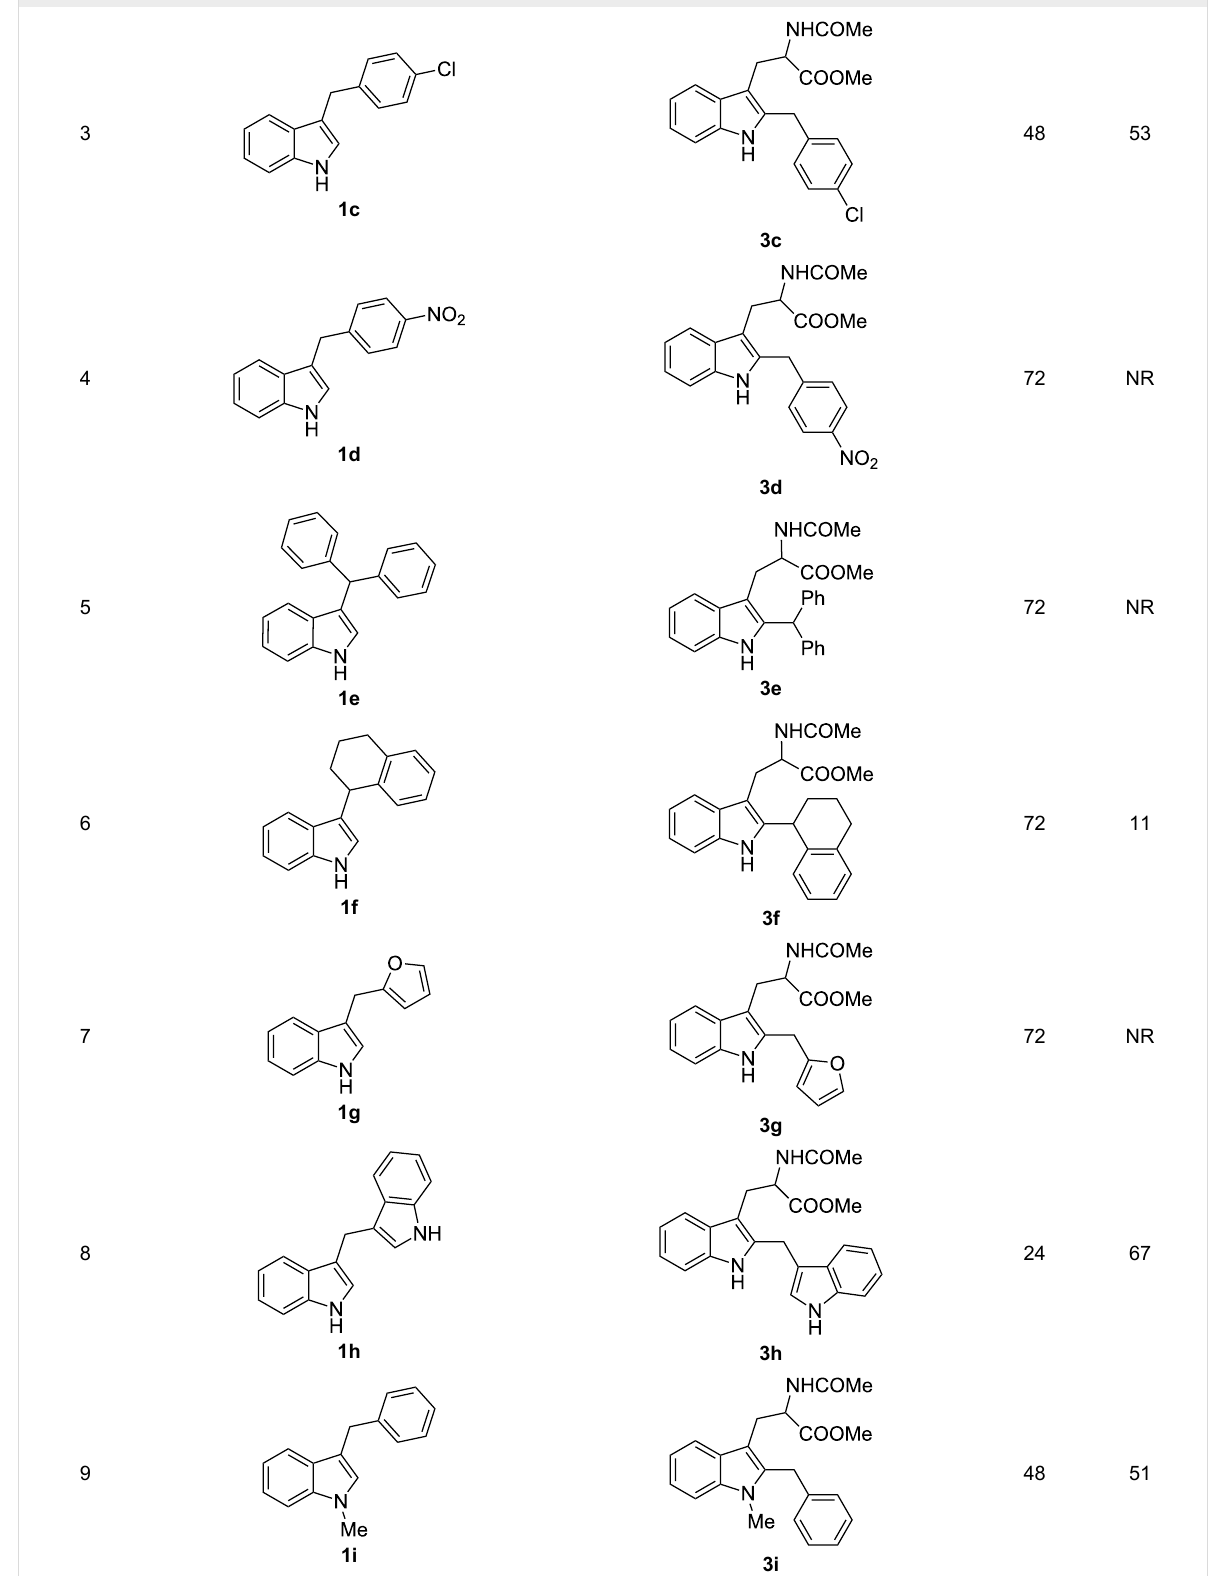
Table 2: Synthesis of 2-benzyltryptophans 3a–j . a